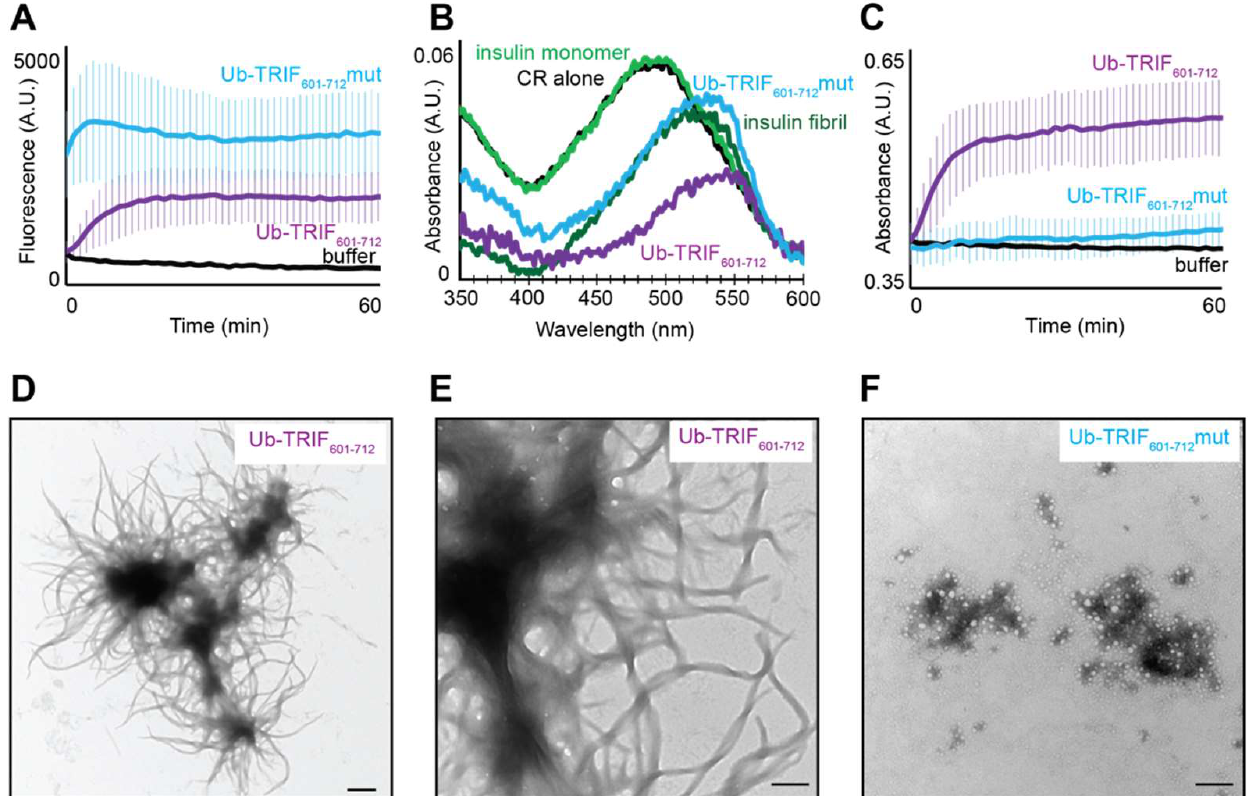
Figure 2. ( A ) Time course of amyloid assembly by Ub-TRIF 601–712 wild type and mut, initiated by dilution from denaturant into assembly-permissive buffer at 2.5 µM, and assessed by ThT fluores- cence. Curves indicate average of three independent replicates, and error bars indicate one standard deviation. ( B ) Congo red absorbance spectra from Ub-TRIF 601–712 WT and mut macromolecular assemblies, compared to insulin monomer, insulin amyloid fibril and Congo red and buffer samples. ( C ) Time course of static light scattering from Ub-TRIF 601–712 RHIM assemblies, following dilution from denaturant into assembly-permissive buffer at 2.5 µM. Curves indicate average from three independent replicates, and error bars indicate one standard deviation. ( D ) Representative trans- mission electron micrograph of 1 µM Ub-TRIF 601–712 assemblies depicting ‘sea anemone’ morphol- ogy. Scale bar 500 nm ( E ) Representative transmission electron micrograph of 1 µM Ub-TRIF 601–712 at higher magnification. Scale bar 200 nm. ( F ) Representative transmission electron micrograph of amorphous 1 µM Ub-TRIF 601–712 mut aggregates. Scale bar 500 nm.